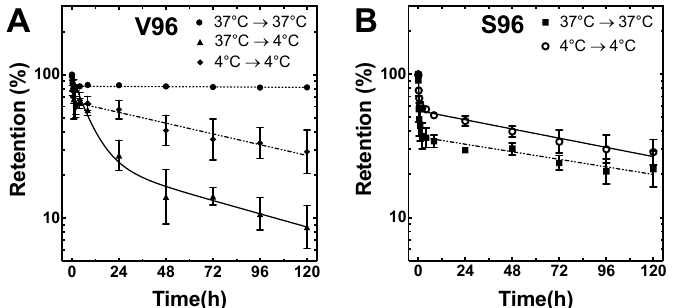
Figure 4. ELP retention on Proclear Compatibles TM lenses depends on ELP T t and incubation temperature. ( A ) Release profiles of group 1 (V96_37 ◦ C → 37 ◦ C), group 2 (V96_37 ◦ C → 4 ◦ C),